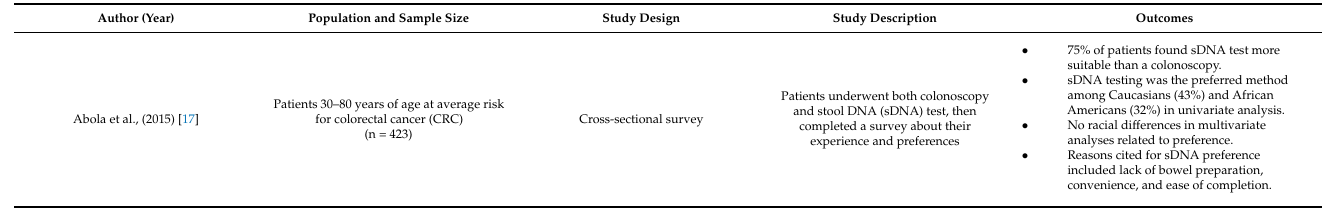
Figure 1. Scoping review schema. This represents each step taken to complete the scoping review. The schema is based on the Preferred Reporting Items for Systematic Reviews and Meta-Analyses Extension for Scoping Reviews (PRISMA-ScR). Table 1. Scoping review article highlights. This table includes key findings from articles retained from the scoping review.